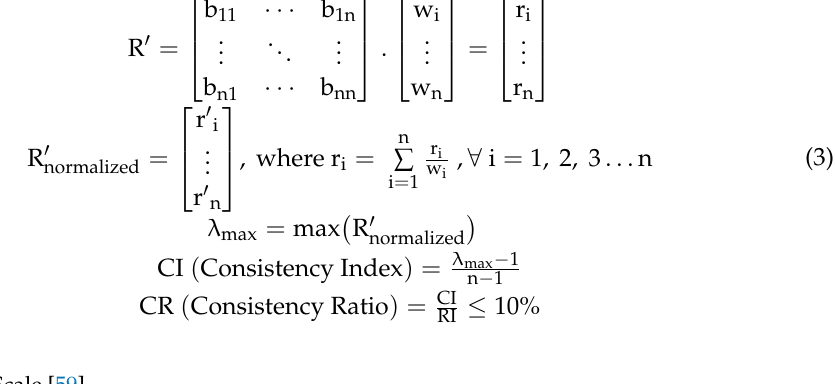
Table 5. AHP Scale [59].